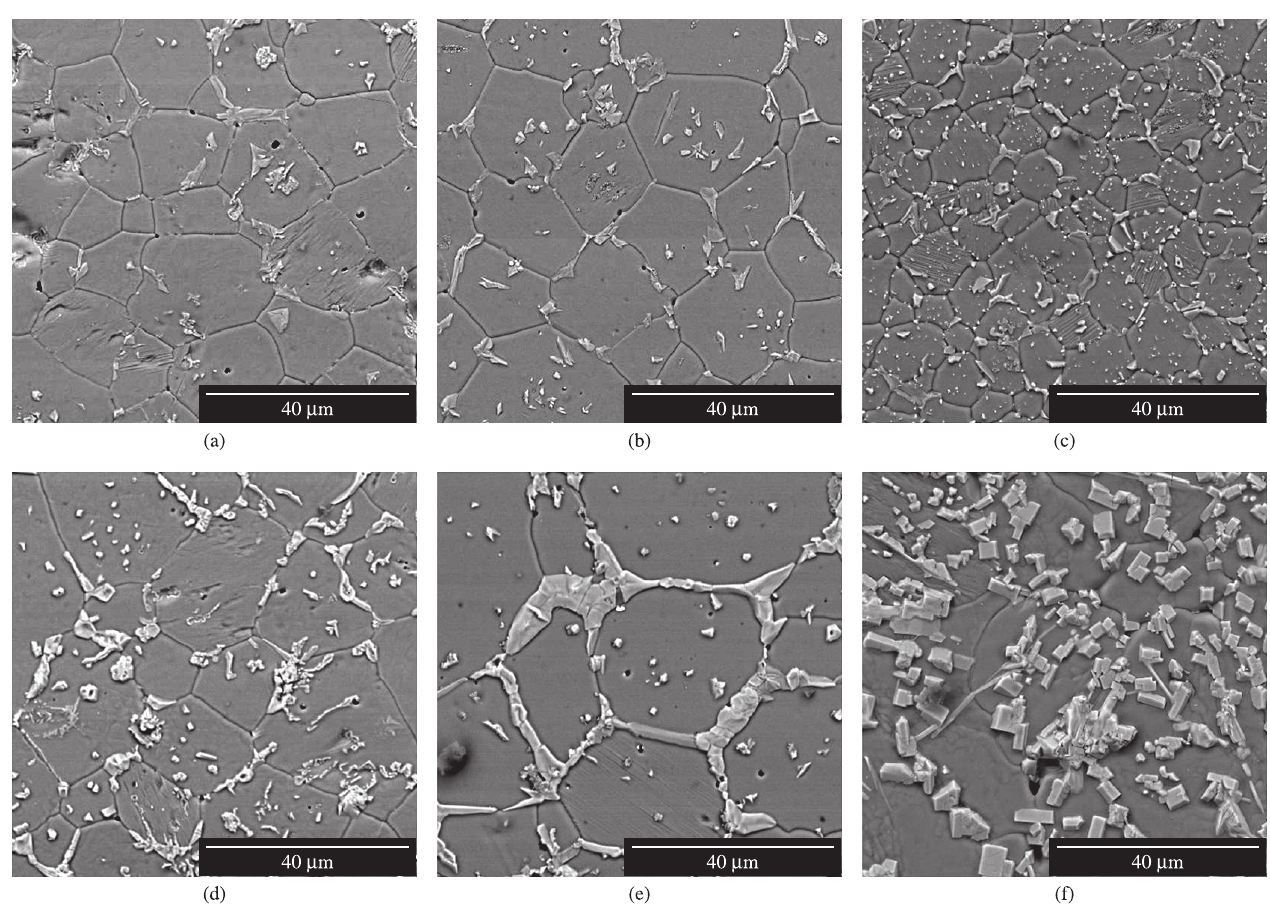
O additive: a) and d) 0.1% Pr 6 11